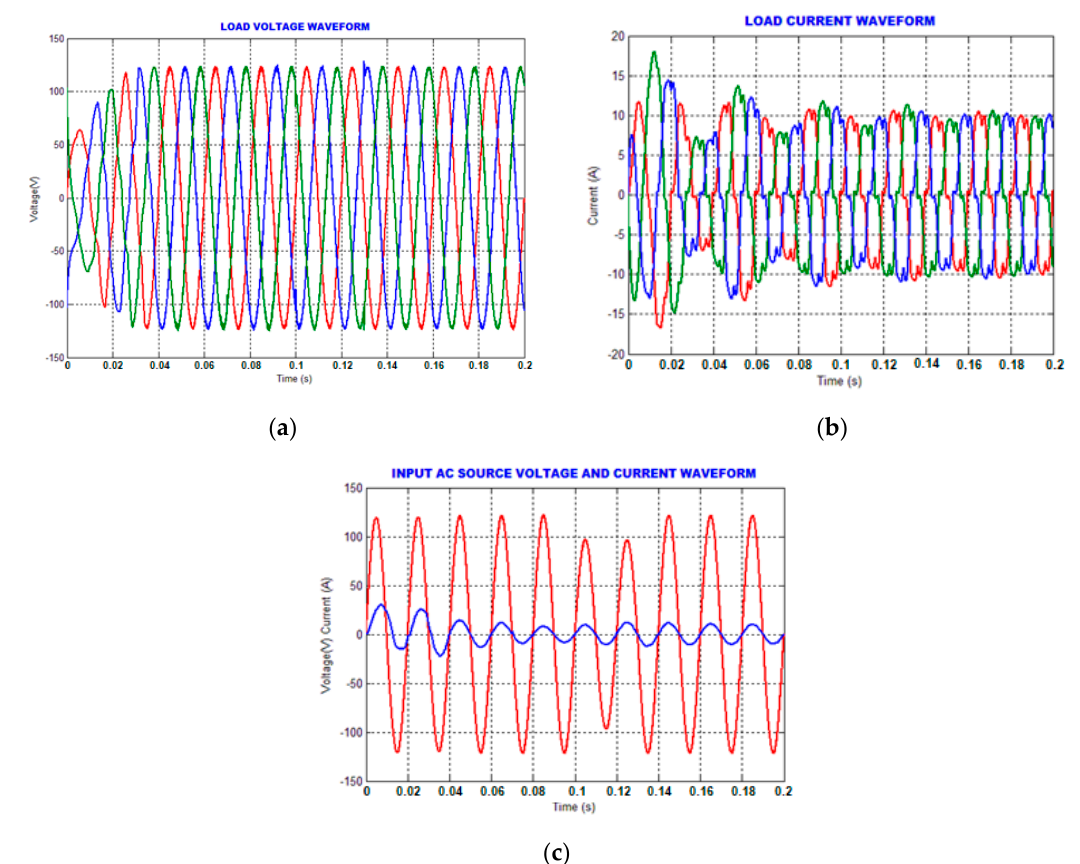
Figure 12. Waveforms for ( a ) load voltage; ( b ) load current; ( c ) source voltage and source current. The waveforms of real power and reactive power, which are developed for a 2 KW system, are illustrated in Figure 13a,b correspondingly. The real power, which is taken